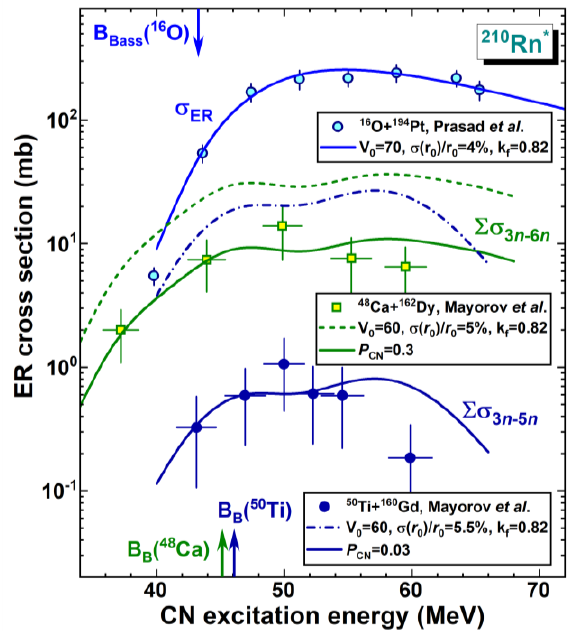
Fig. 4. The same as in Fig. 3 but for ER cross sections obtained in reactions leading to the 210 Rn * CN [12, 13] and calculations with k f =0.82. In the cases of 48 Ca and 50 Ti, P CN =0.3 and 0.03, respectively, have to be introduced to describe the data.